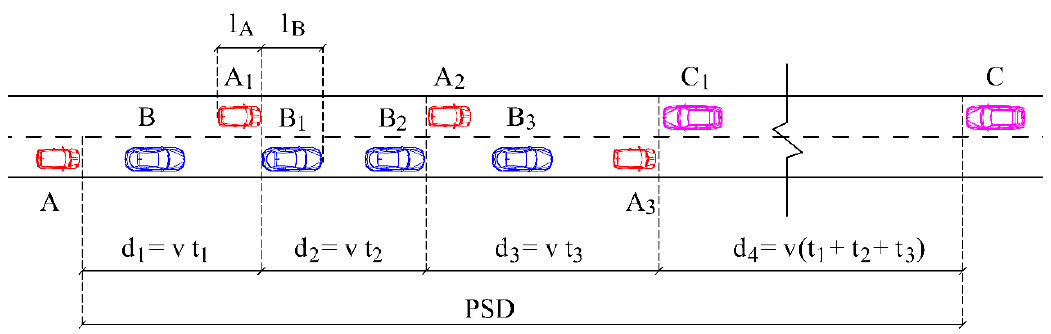
Figure 1. Overtaking maneuver phases (Italian model [10,22]).